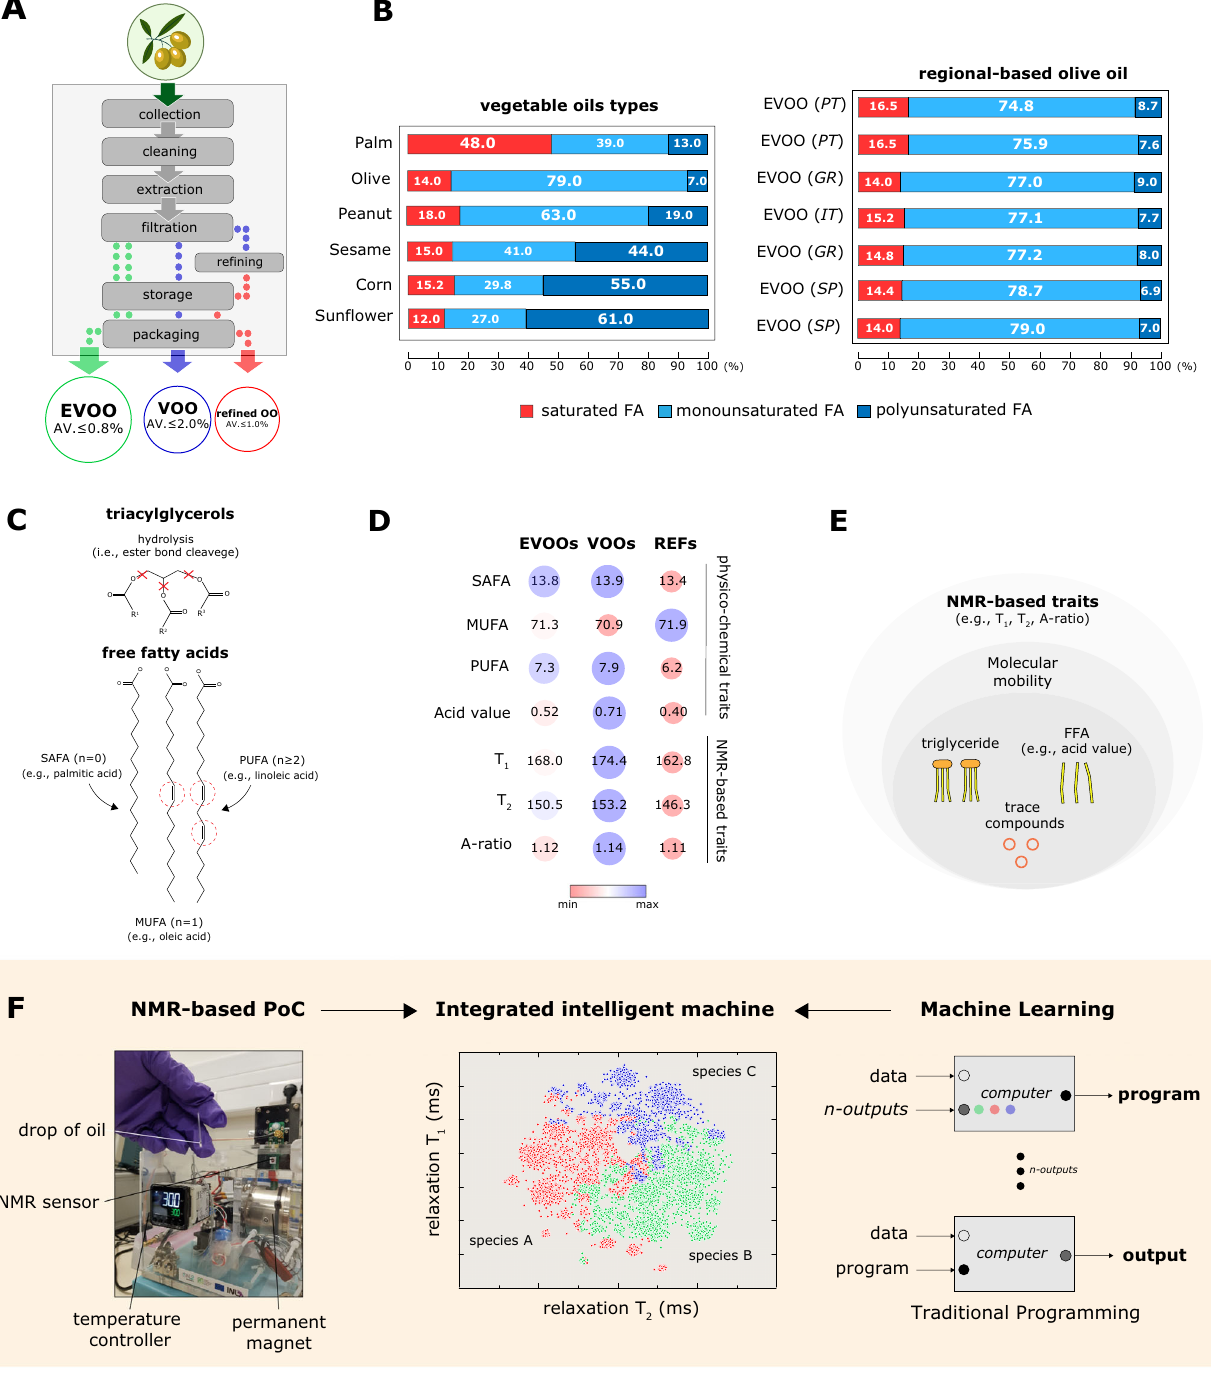
VOOs and re fi ned OO (Fig. 2). The relaxometry measurements and acidity determination (details in Methods) were performed on thirty-six types of OOs (i.e. 21 EVOOs, 8 VOOs, and 7 re fi ned OOs,) without disclosing the manufacturers label and country of origin. For each sample, the relaxation measurements were carried out using fi ve different samplings, with the re fi ned OO was performed as control experiment. A two-dimensional map T 1 -T 2 magnetic state diagram was used to enumerate the object clustering based on the composite intrinsic relaxation properties of the oils, thereof, forming